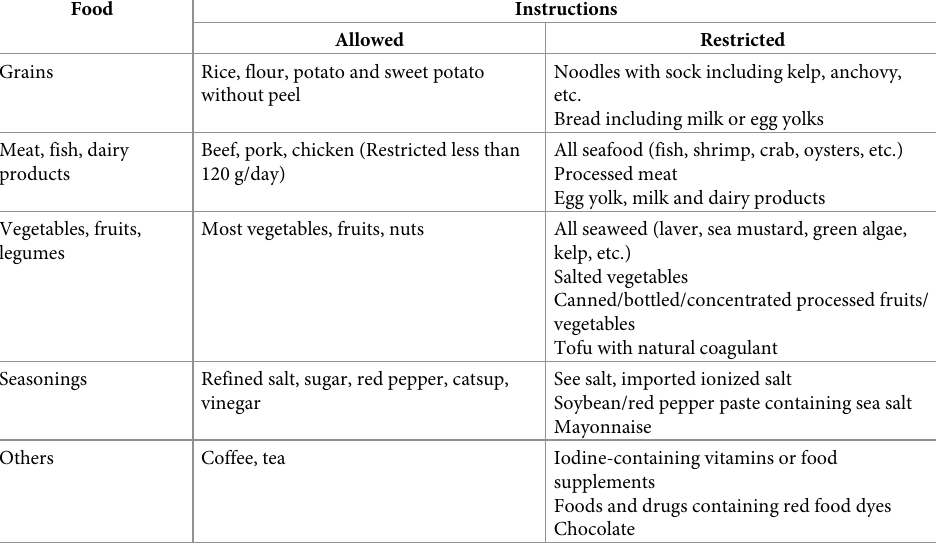
Table 1. Instructions of LID for RAI treatment or scan. Food Instructions Allowed Restricted Grains Rice, flour, potato and sweet potato Noodles with sock including kelp, anchovy, without peel etc. Bread including milk or egg yolks Meat, fish, dairy Beef, pork, chicken (Restricted less than All seafood (fish, shrimp, crab, oysters, etc.) products 120 g/day) Processed meat Egg yolk, milk and dairy products Vegetables, fruits, Most vegetables, fruits, nuts All seaweed (laver, sea mustard, green algae, legumes kelp, etc.) Salted vegetables Canned/bottled/concentrated processed fruits/ vegetables Tofu with natural